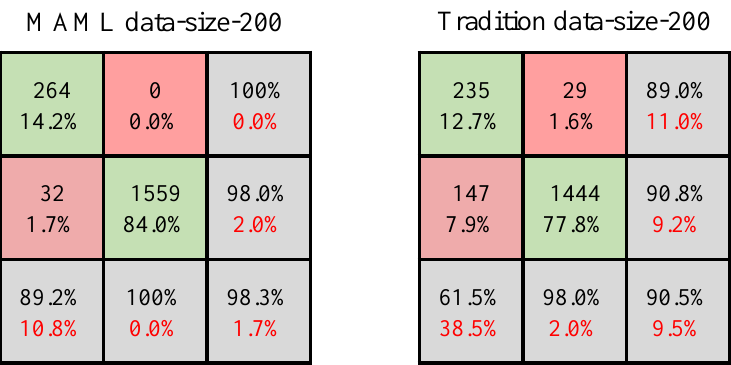
Figure 17. Confusion matrix of MAML-ANN and traditional ANN for different data